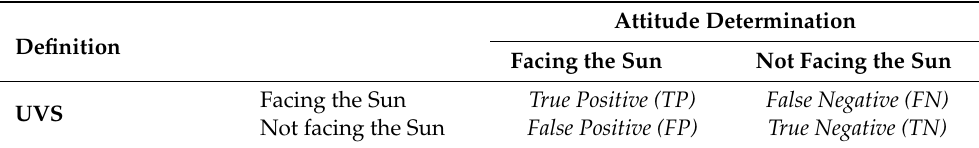
Table 2. Definition of the true positive, false negative, false positive, and true negative.